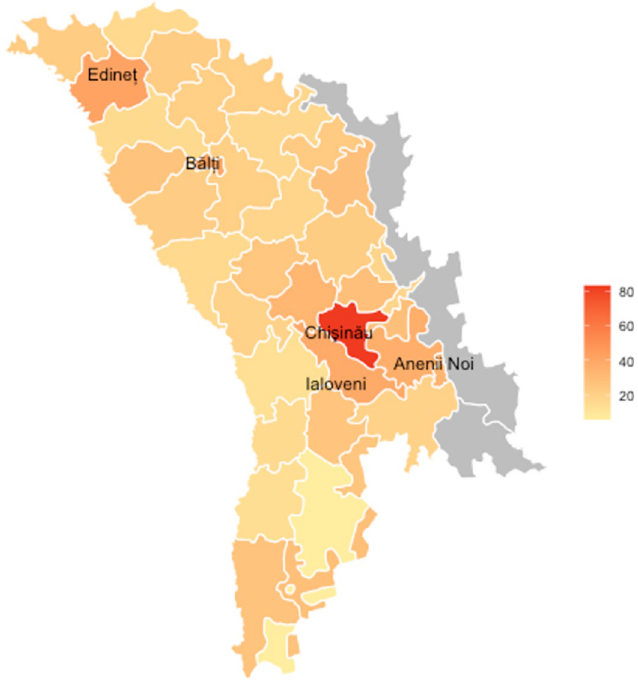
Fig 1. Cumulative cases of COVID-19 per thousand as of 21 st December 2020. Source—https://covid19.who.int/ region/euro/country/md; Authors’ own illustration; Reprinted under a CC BY license, with permission from UNHCR, original copyright 2021: https://data.humdata.org/dataset/moldova-administrative-level-0-1-boundaries.